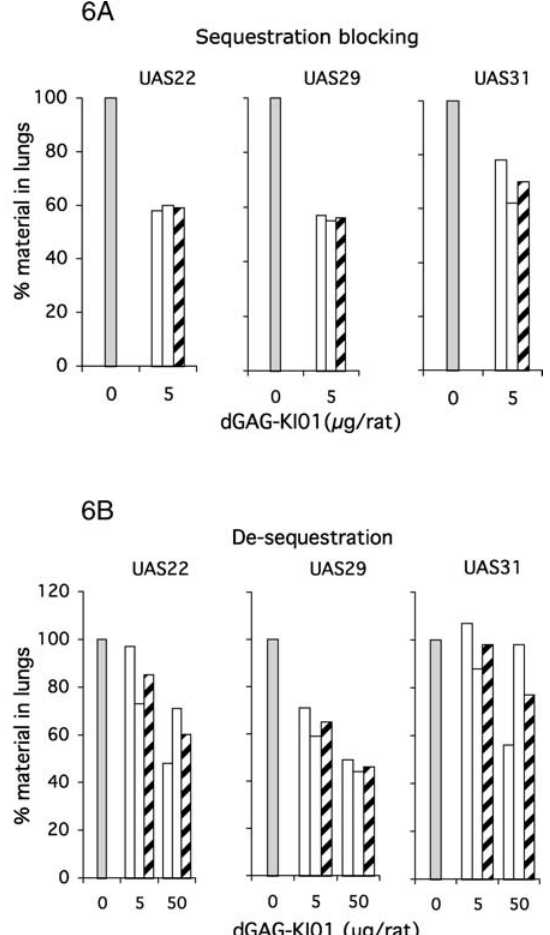
Figure 6. Injection of dGAG-KI01 Decreases P. falciparum Sequestration of IE of Clinical Isolates in the Rat (A) Rats were co-injected with 99m Tc-labeled IE (clinical isolates: UAS22, UAS29, and UAS31) and 5 l g of the dGAG-KI01, or (B) rats were first administrated with 99m Tc-labeled IE (clinical isolates: UAS22, UAS29, and UAS31) and after 3 min, injected with different concentrations of the dGAG-KI01. Rats were in all cases left in the gamma camera for 30 min, after which the lungs were excised, measured for radioactivity, and compared to the level of radioactivity in the whole animal. Results are presented as relative amount in lungs compared with control animal receiving no dGAG-KI01 (control, adjusted to 100%; grey bars). White bars show the results of individual rats, and the striped bars, the mean thereof. DOI: